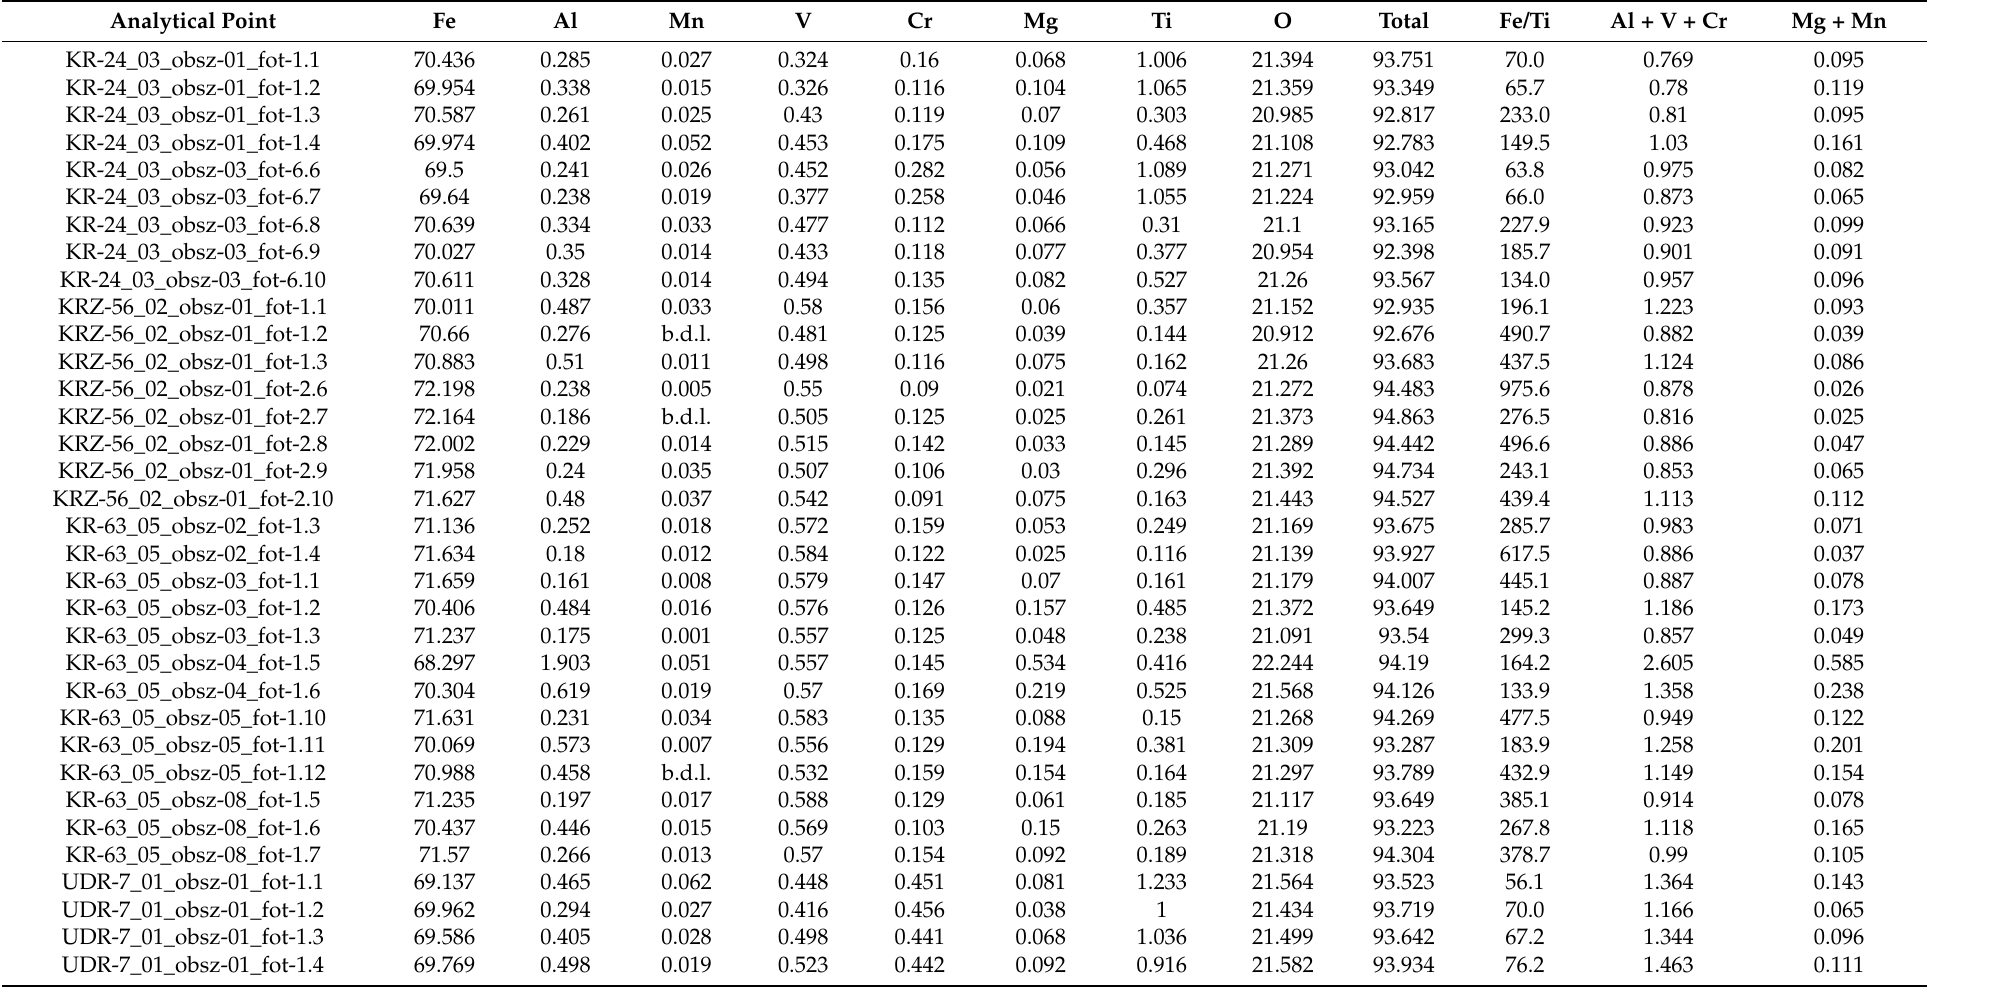
Table A1. Chemical composition of magnetite from the Krzemianka and Udryn Fe-Ti-V deposits in NE Poland identified via